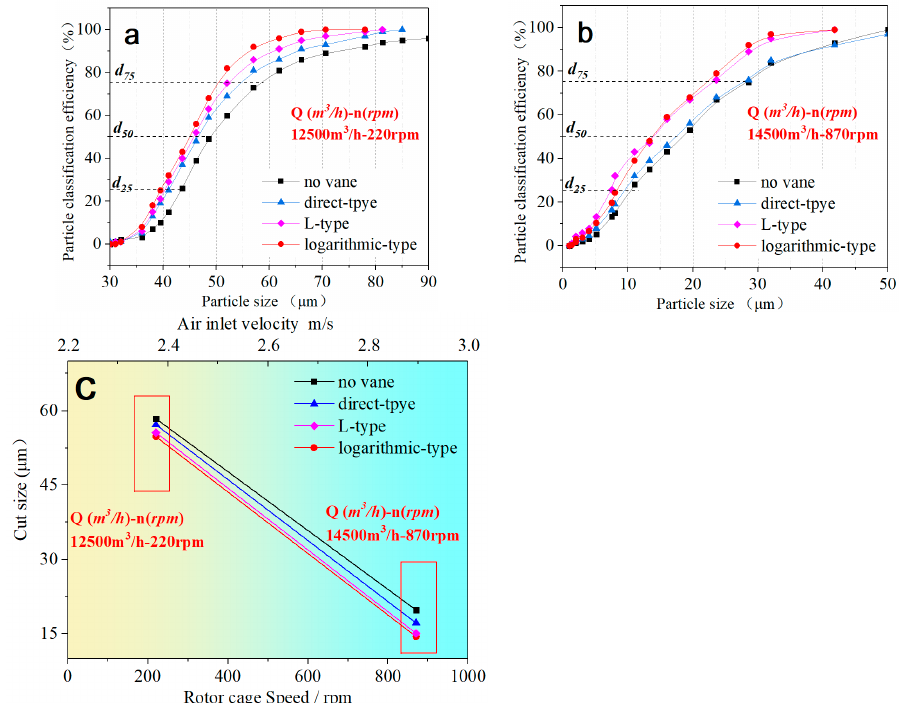
Figure 14. Numerical particle classification efficiency curves and cut size of four different guide vane structures by two processes. ( a ) Tromp curves by the processes of Air inlet flow rate: 12,500 m 3 /h and rotor cage speed 220 rpm; ( b ) Tromp curves by the processes of Air inlet flow rate: 14,500 m 3 /h and rotor cage speed 870 rpm; ( c ) Cut size by two different processes.